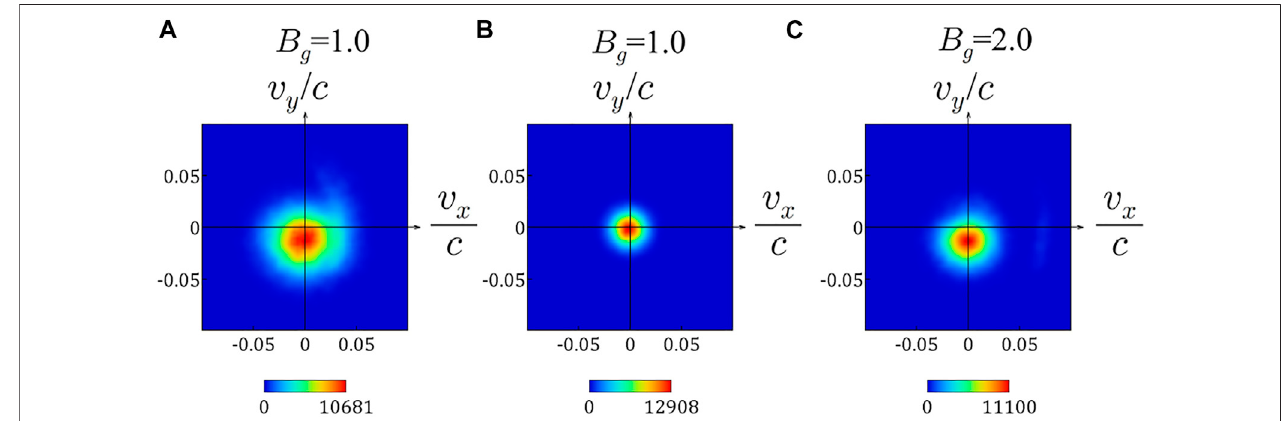
FIGURE 8 | Ion velocity distributions (A) : in the boxed area (u1) designated in Figure 5C at ω pi t = 775 for B g = 1.0 (B) : at the initial time, and (C) : in the area (u1) at ω pi t = 775 for a different simulation run of B g = 2.0.